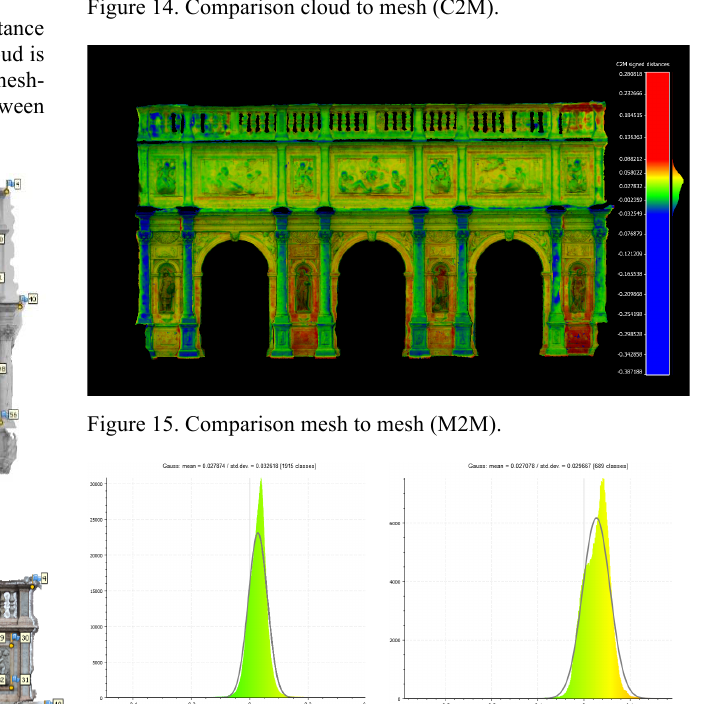
Figure 14. Comparison cloud to mesh (C2M).